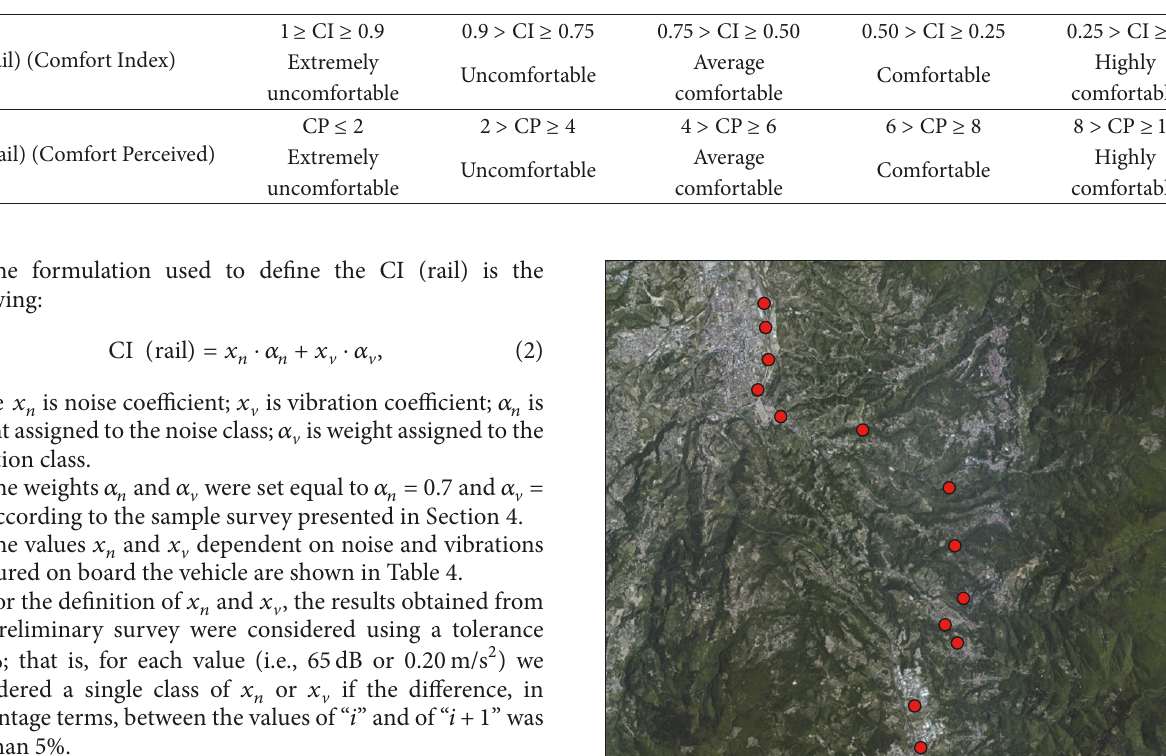
Table 5: Determination of comfort index (CI) (rail) and perceived comfort (CP) (rail).